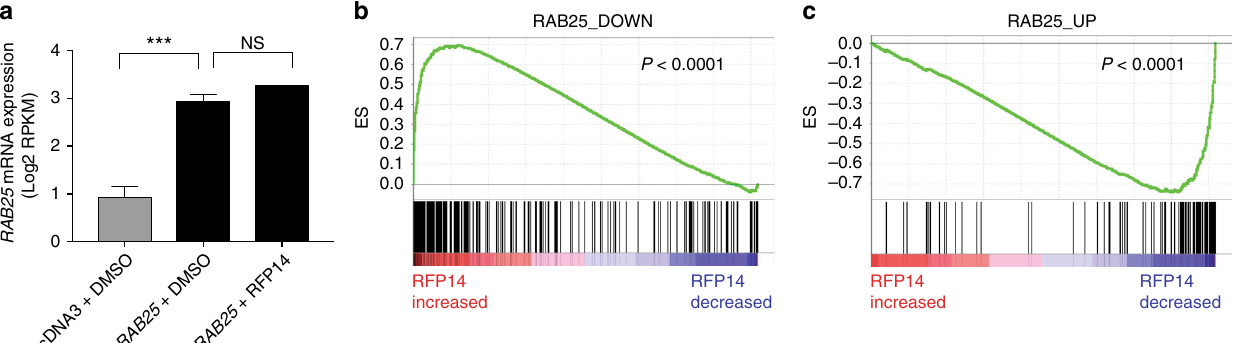
Fig. 6 RFP14 inhibits RAB25-dependent gene expression in ovarian cancer cells. a Relative RAB25 mRNA levels in pcDNA3-HEY cells treated with DMSO, RAB25- expressing HEY cells treated with DMSO, and RAB25- expressing HEY cells treated with RFP14 measured by RNA-Seq pro fi ling. b , c Quantitative GSEA plots of RAB25_UP and RAB25_DOWN gene set enrichment within the RFP14 vs. DMSO gene expression pro fi le in RAB25 -expressing HEY cells. Both RAB25-depenent gene sets were signi fi cantly enriched in the RFP14 vs. DMSO pro fi le as indicated by the GSEA results for RAB25_DOWN (ES = 0.70, NES = 1.35, P < 0.0001) and RAB25_UP (ES = − 0.74, NES = − 1.61, P < 0.0001). The data represents two technical replicates from two independent biological replicate experiments. ES, enrichment score; NES, normalized enrichment score; NS, not signi fi cant. *** P < 0.005, Student ’ s t